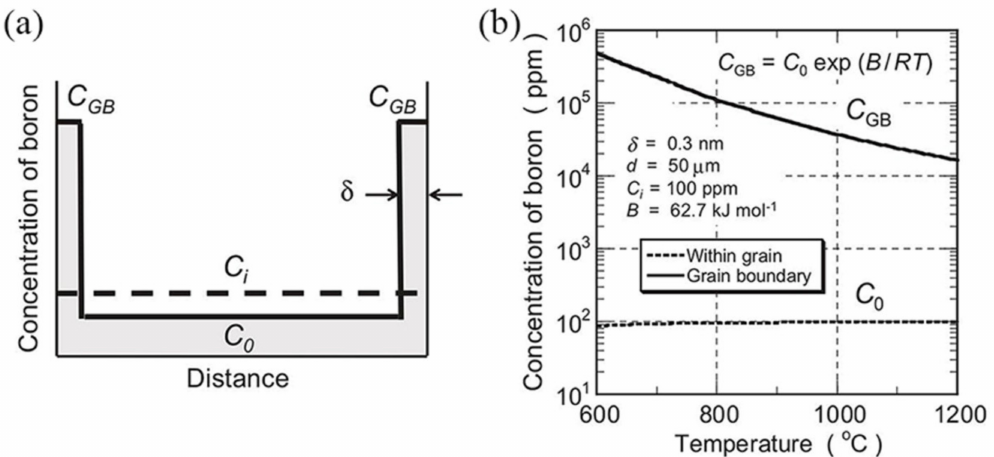
Figure 8. ( a ) Boron concentration profile [81] and ( b ) boron concentration at grain boundary ( C GB ) and in interior of grain ( C 0 ) vs. temperature